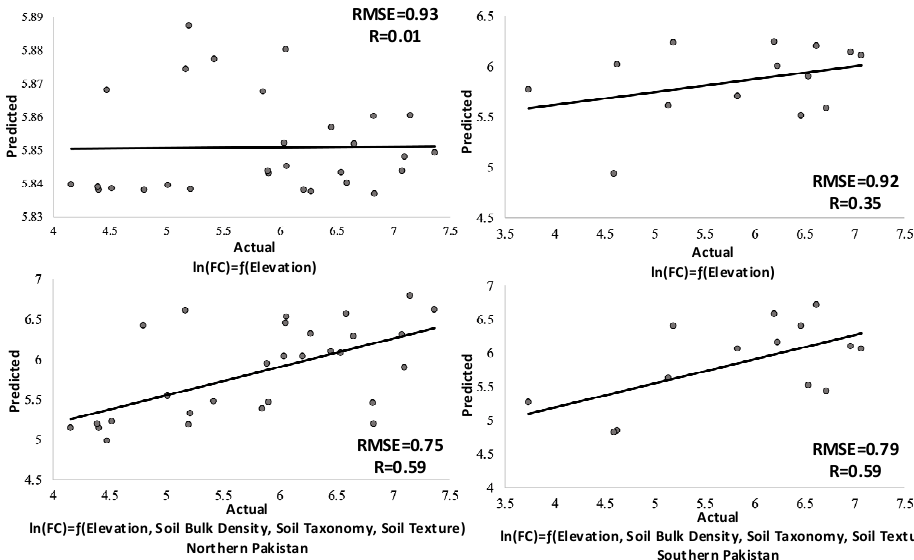
Figure 10. Monthly FC (Predicted) was calculated and compared to satellite-observed FC (Actual) in Northern and Southern Pakistan from 2016 to 2020. FC predictions were derived using Table 2’s daily-based models. RMSE = Root Mean Square Error; R = Pearson Correlation Coefficient; R = Pearson Correlation Coefficient; R = Pearson Correlation.